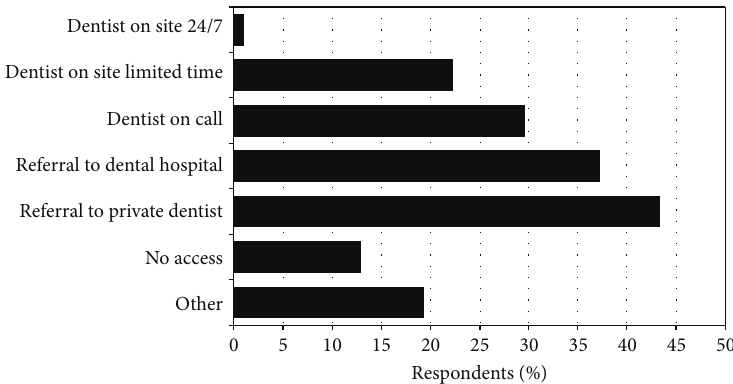
Figure 1: Percentage of respondents according to access to dental services from ED (more than one response accepted).